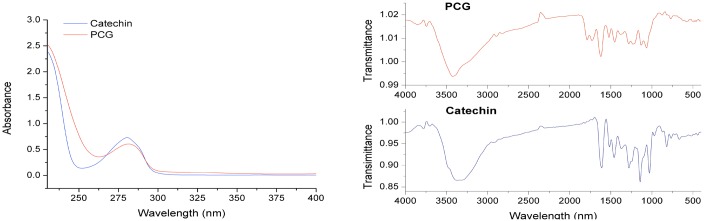
UV and IR spectra of catechin and PCG.